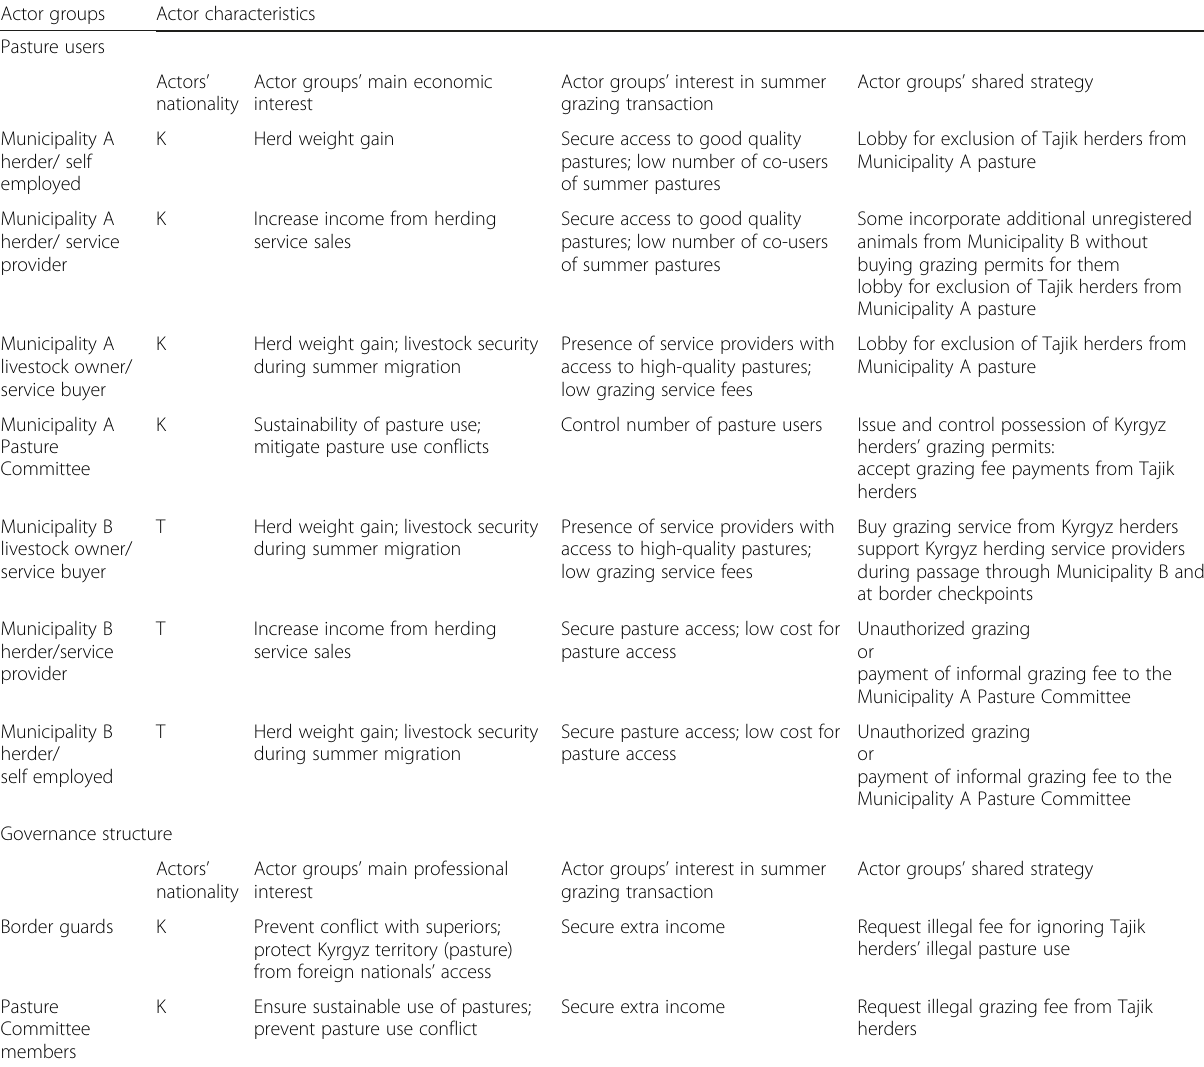
Table 3 Conflict partners and their conflicting positions on transboundary pasture use around the Tajik enclave, Municipality